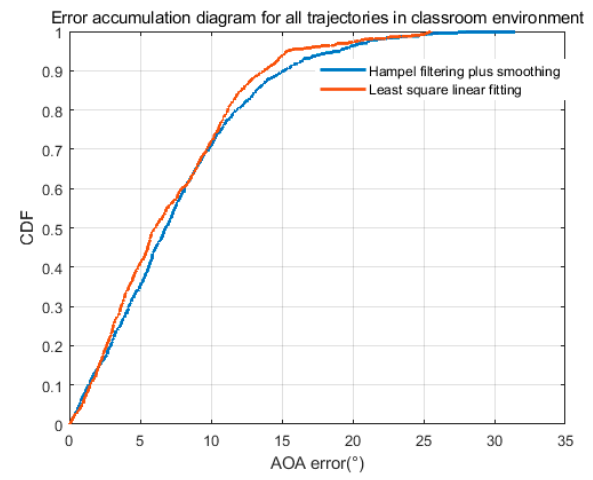
Figure 20. AOA error accumulation diagram of two different filtering methods.